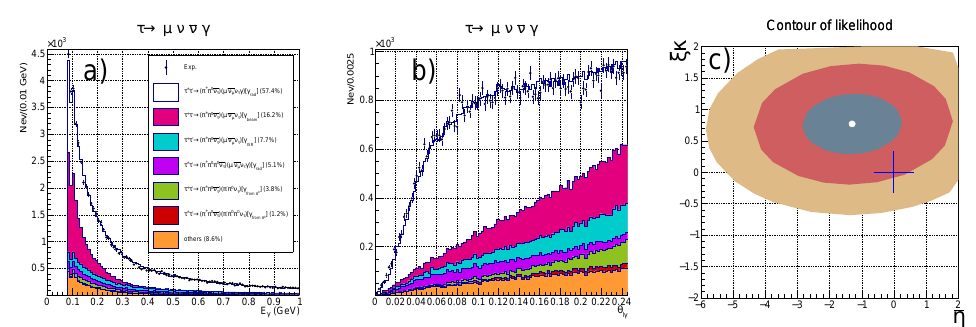
Figure 1. For the ( µ − γ ; ρ + ) sample: (a) photon energy E γ , (b) spatial angle θ µγ and (c) 1 σ - 2 σ - and 3 σ -contours of the likelihood function on the ¯ η − ξκ plane, the cross indicates SM prediction. Dots with error bars are experimental data and histograms are MC